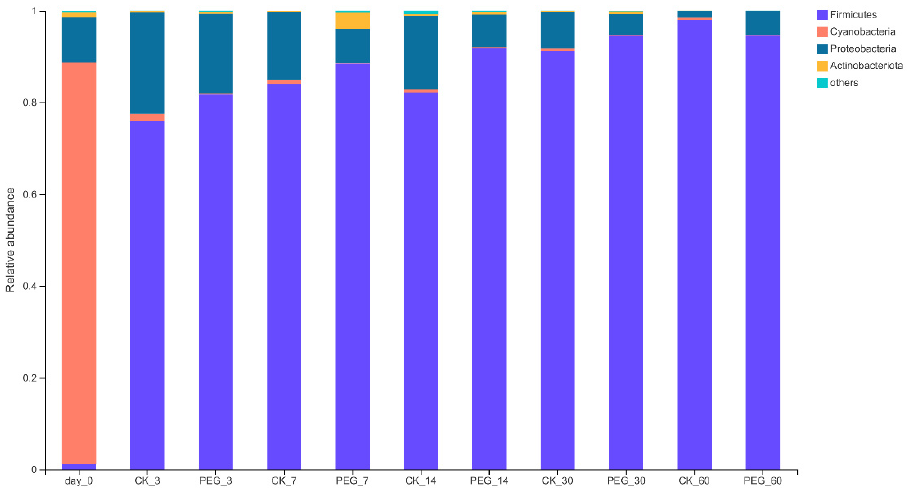
Figure 2. Relative abundance of bacterial community on the phylum level of PEG-treated and control group of sainfoin silage (CK_3: on day 3 of control ensiling; PEG_3: on day 3 of PEG-treated ensiling, same as others).